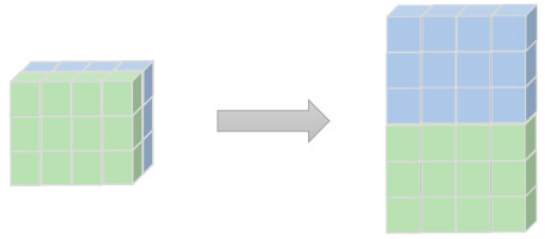
Figure 7. 3D feature-length expansion diagram.